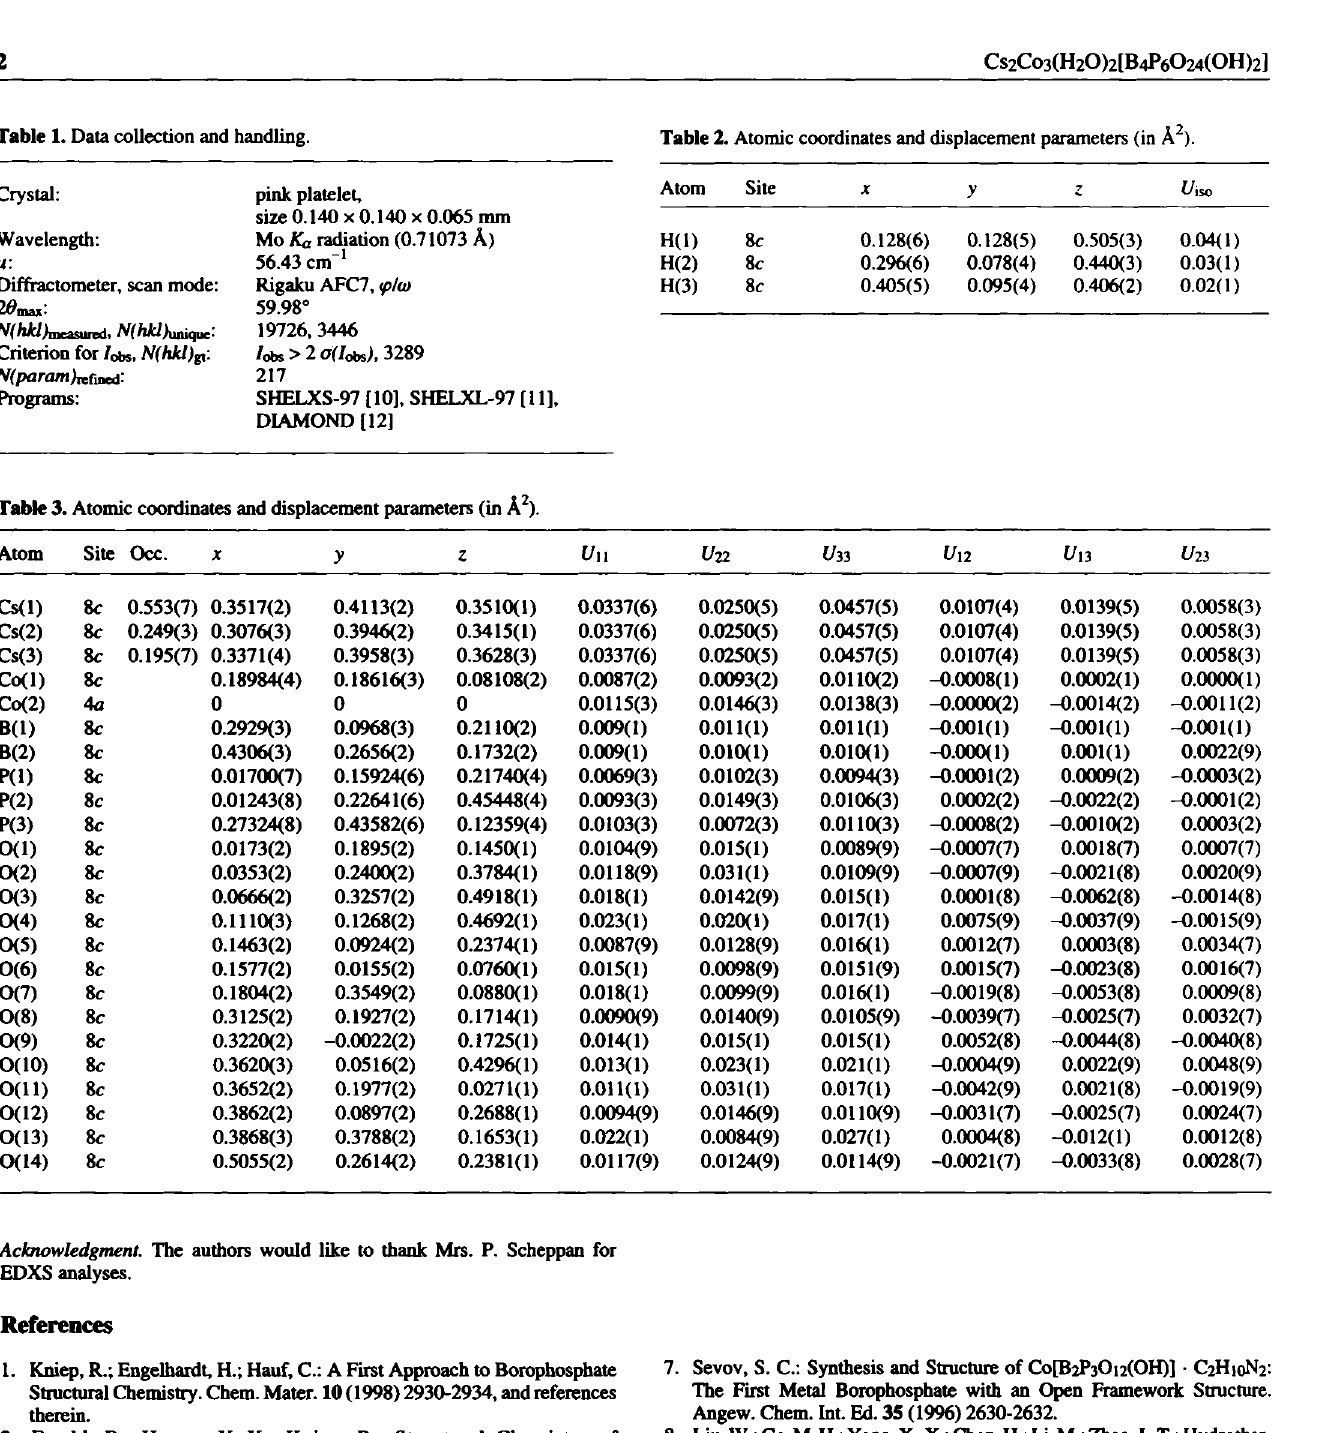
Table 1. Data collection and handling. Table 2. Atomic coordinates and displacement parameters (in Ä 2 ).